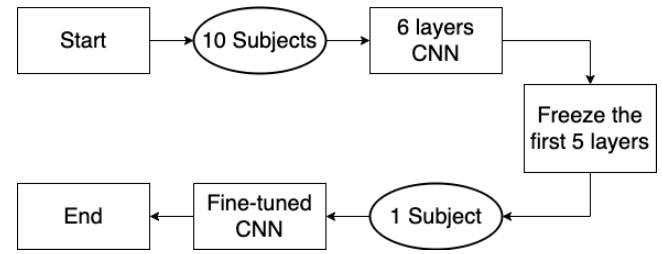
Figure 9. The flowchart of fine-tuning